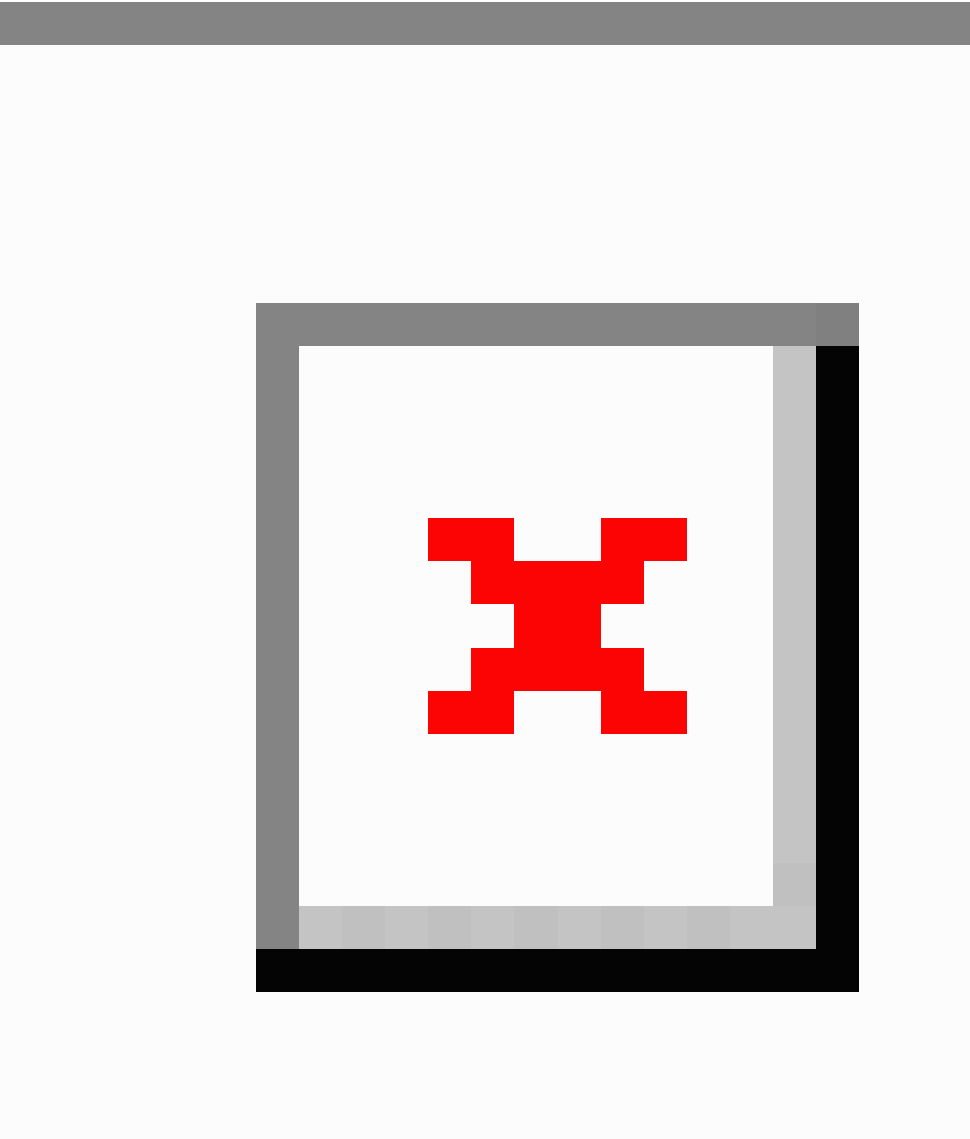
Figure 1. Image of the tablet app of the German version of the Multiple Sclerosis Health-Resource Utilization